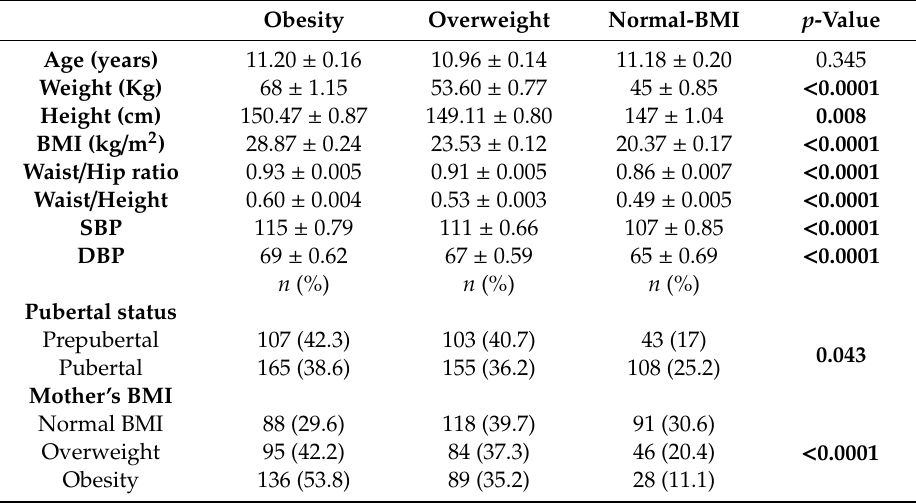
Table 2. Clinical characteristics of all subjects after a year of